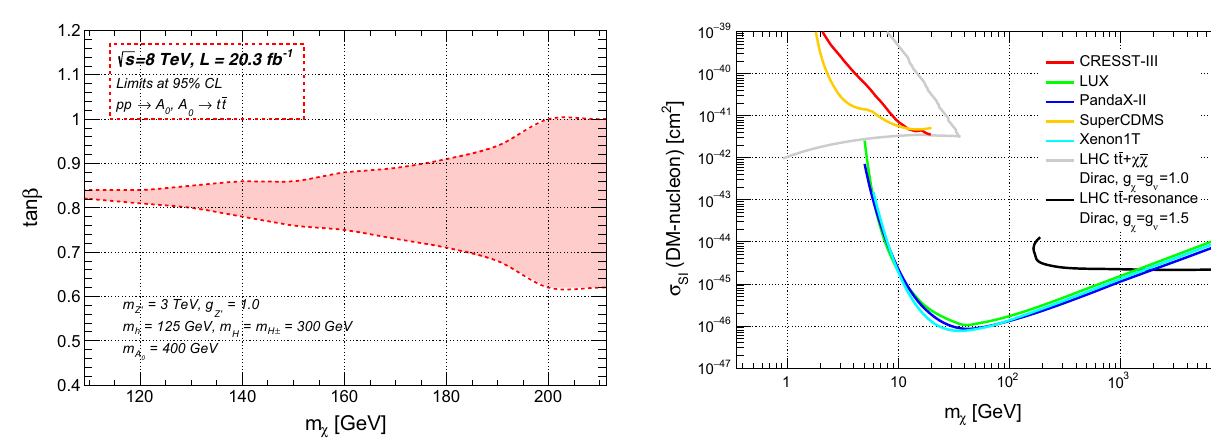
Fig. 4 Exclusion contour for 2HDM+ Z (cid:5) model in the ( m χ , tan β) plane. The contour corresponds to the excluded values of the model. All of the other parameters of the model are fixed and mentioned in the figure. Only results using the t ¯ t resonance signature are presented, sinceothersignaturesdonotexcludeanypartofthepresentedparameter space